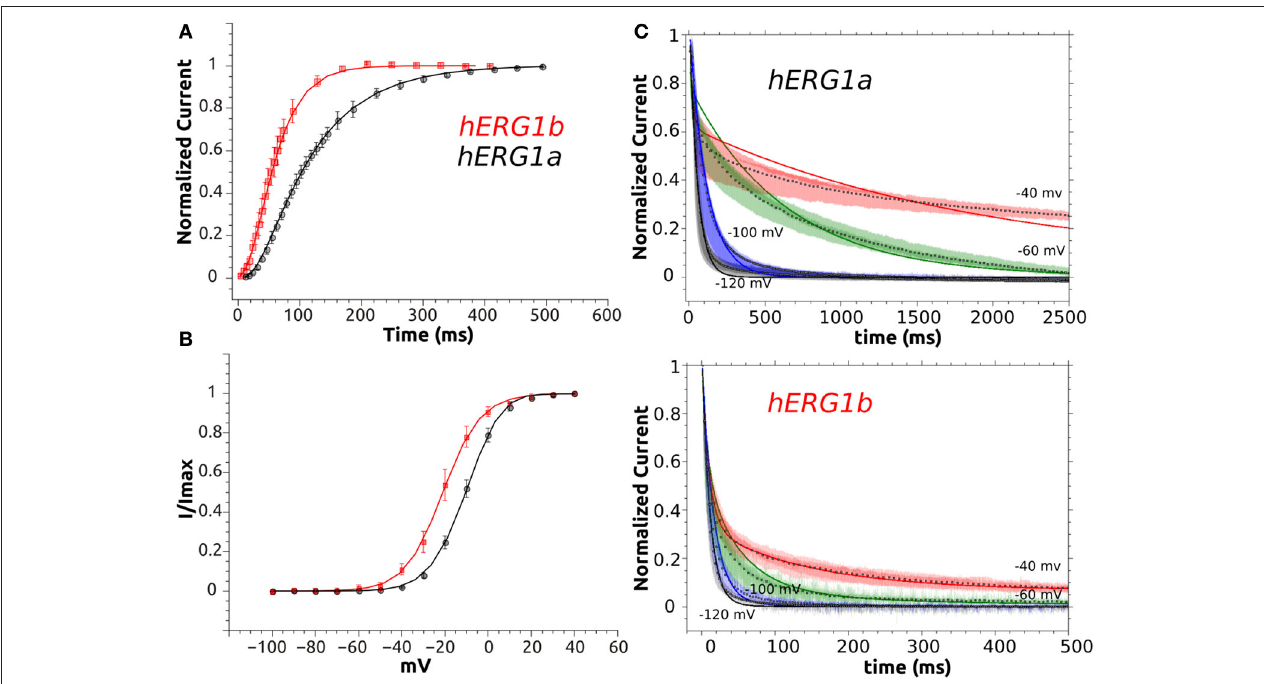
FIGURE 6 | M-model 1 optimization to experimental data. (A) Activation curve of a-isoform and b-isoform. (B) Steady State Activation curve for both isoforms. (C) Simulated deactivation curves at − 120, − 100, − 60, and − 40mV. Simulated data is shown as solid lines and symbols are used for experimental time course data (average, n = 10). Superimposed raw time course data ( n = 10) is shown in the background for deactivation at each